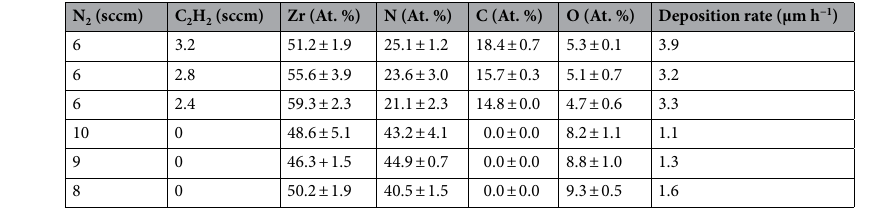
Table 2. Deposition conditions, EDS composition and deposition rates of the multilayer films used to determine the films deposition parameters.